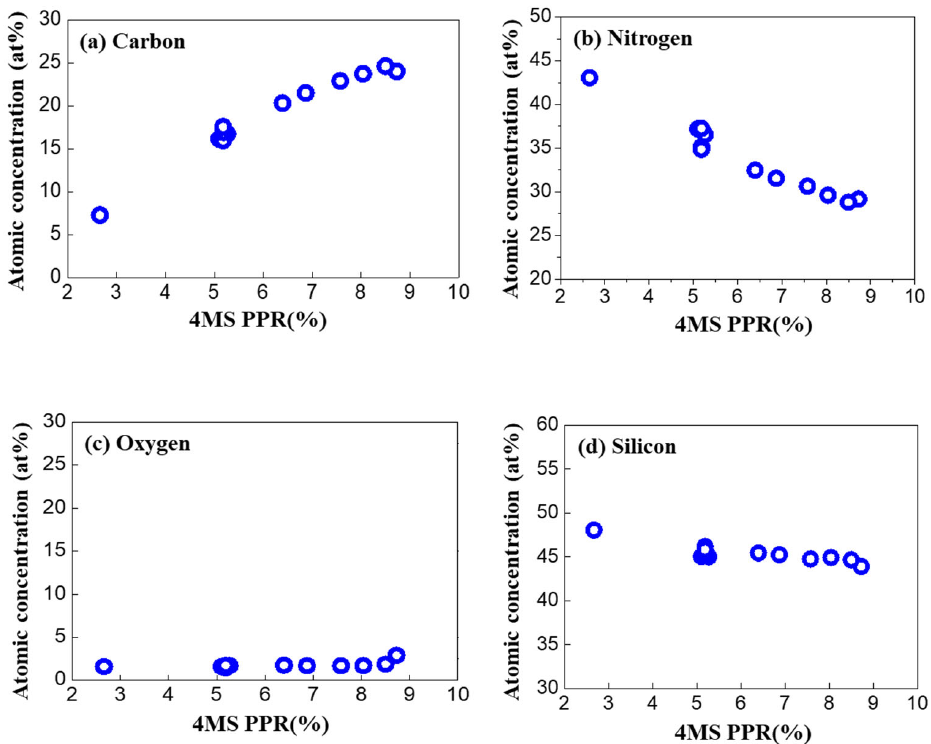
Figure 3. The composition ratio at the one-fourth point of the SiCN thin film according to 4MS PPR. ( a ) Carbon, ( b ) nitrogen ( c ) oxygen, and ( d ) silicon.